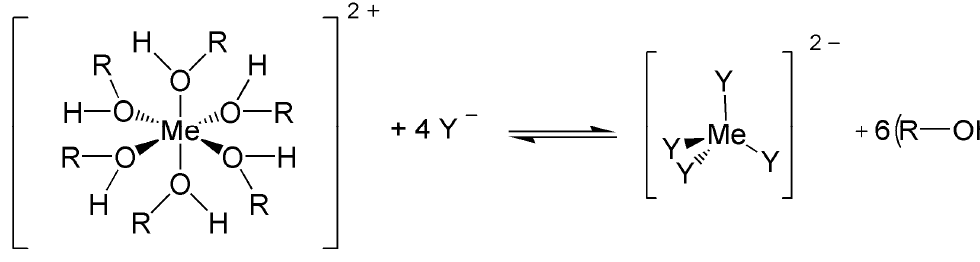
Figure 4. Ligand exchange in Ligand-Exchange Thermochromic Systems